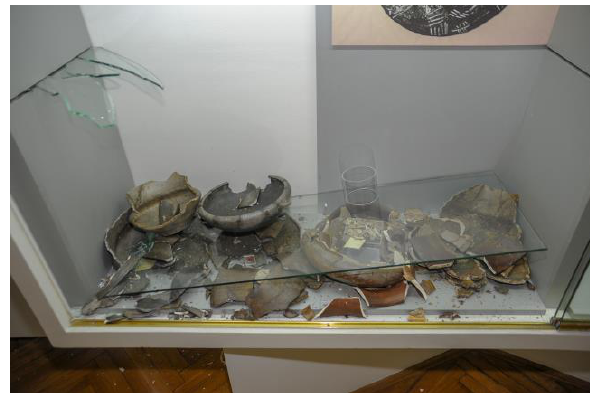
Figure 7: Earthquake damage in the Prehistoric section of